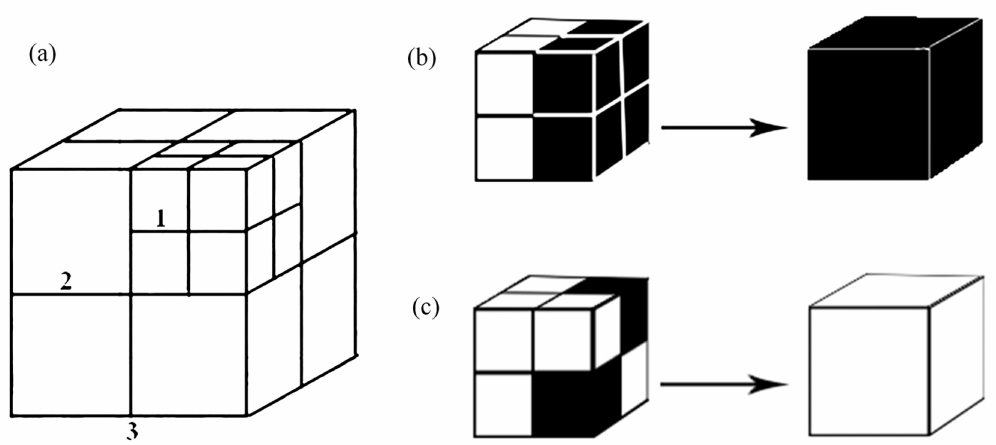
Figure 1. Renormalization model and renormalization transformation of rocks: ( a ) renormalization